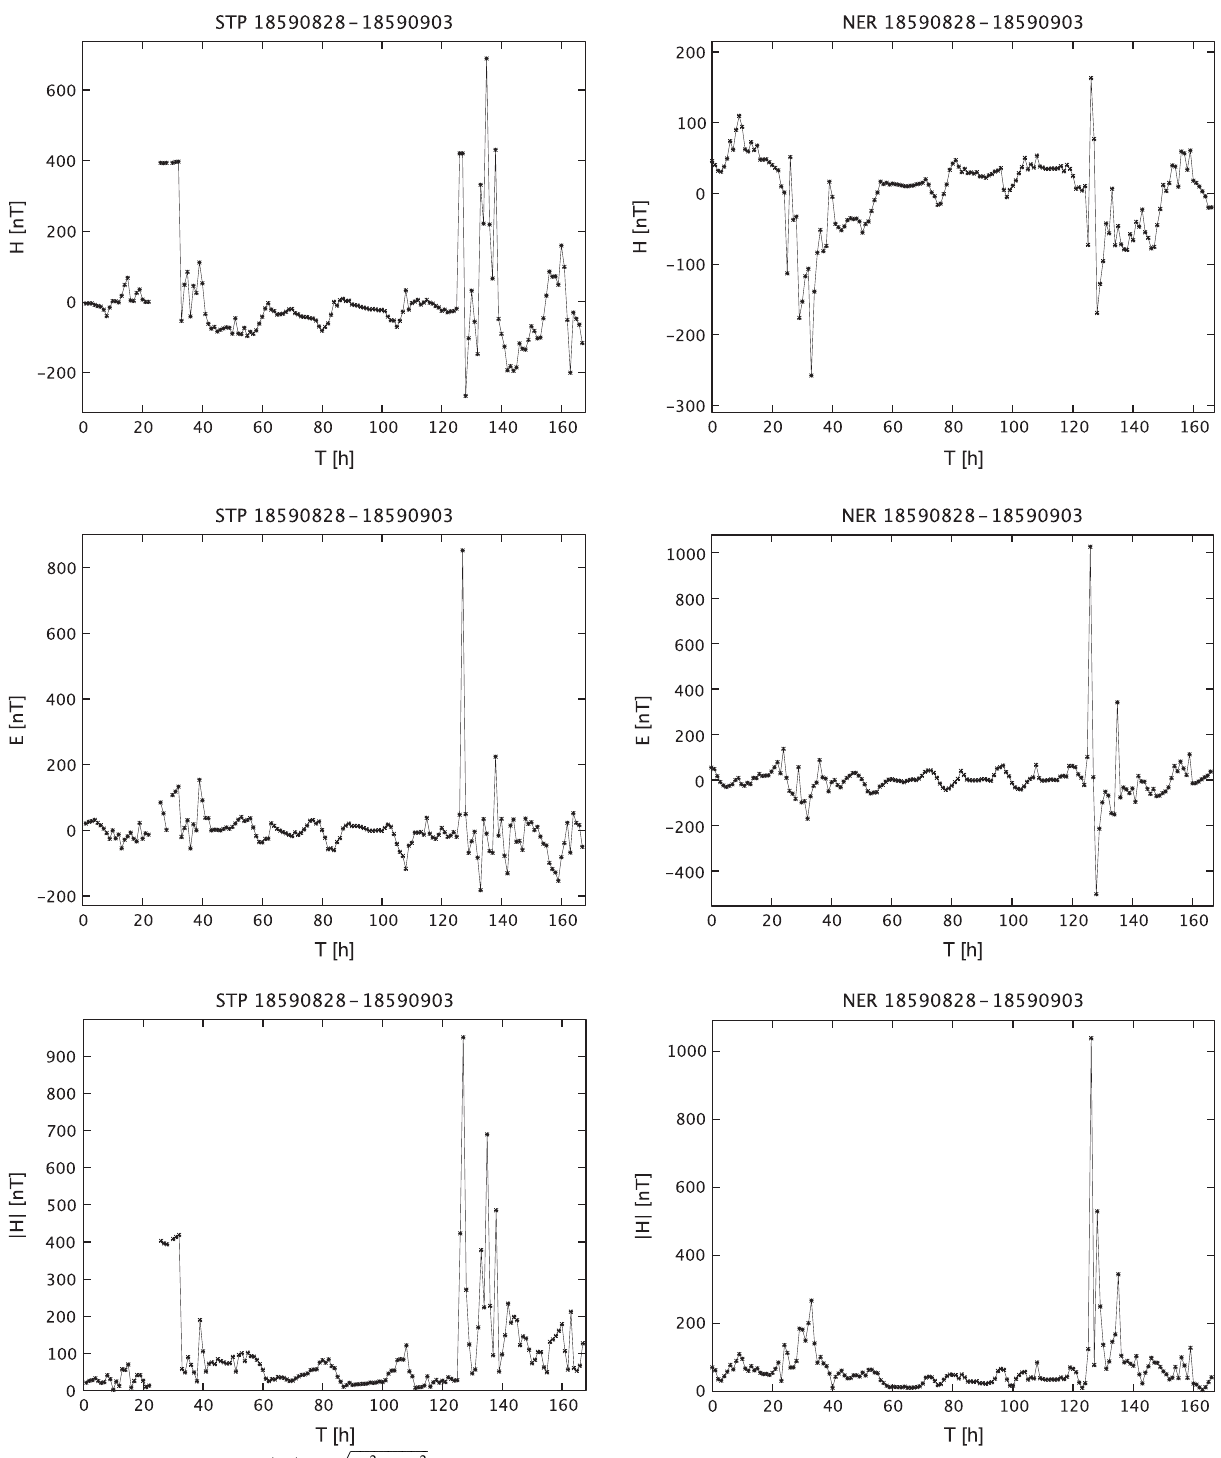
Fig. 7. Recordings of H , E and H j j ¼